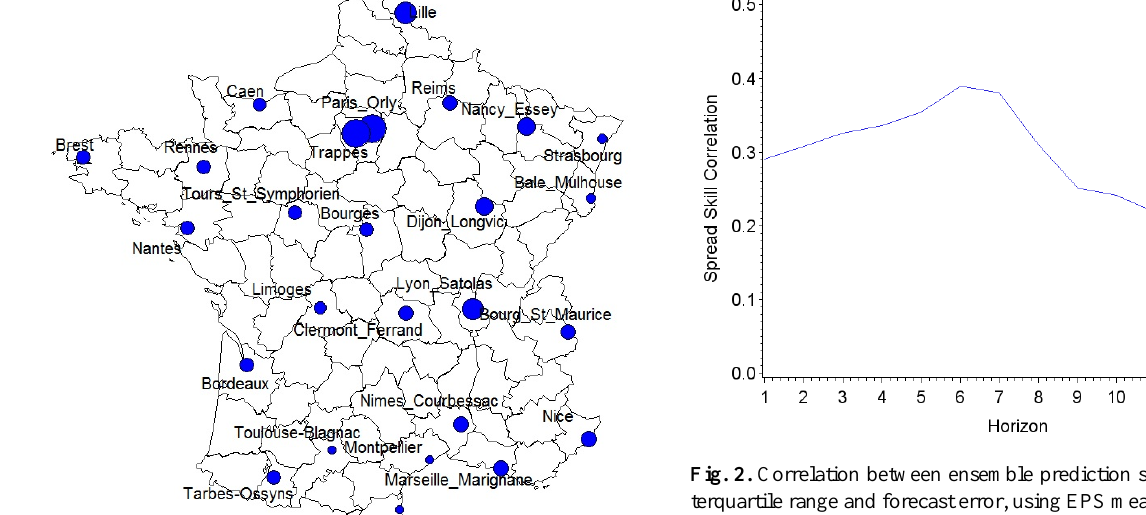
Fig. 3. Mean forecast error, using Ensemble Prediction Sys-